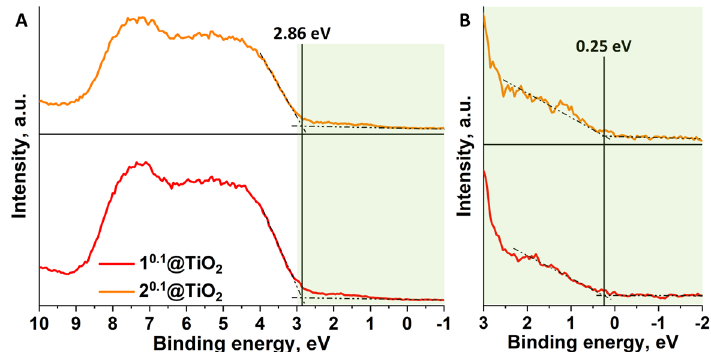
Figure 9. ( A ) Valence-band XPS spectra of n 0.1 @TiO 2 ; ( B ) Enlarged part of the left spectra (colored in green).